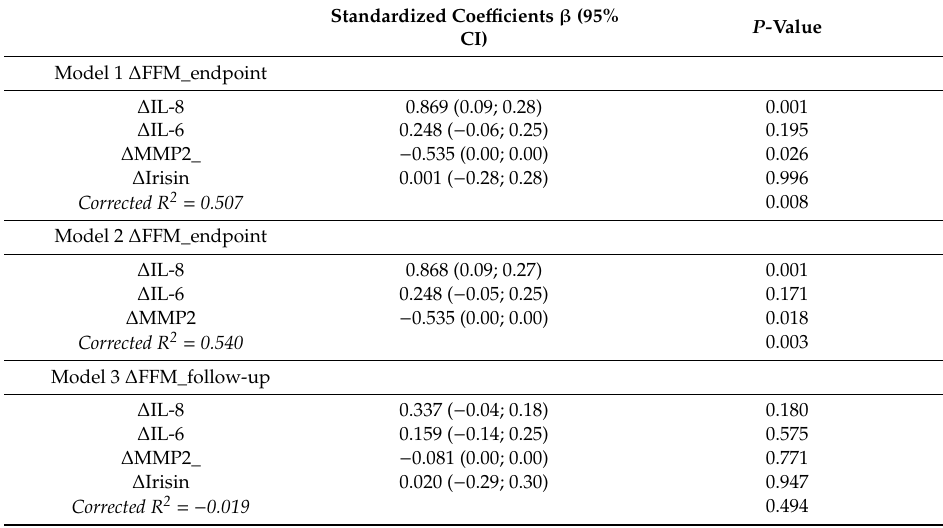
Table 3. Independent e ff ects of changes from baseline in myokine levels on fat free mass following the weight loss